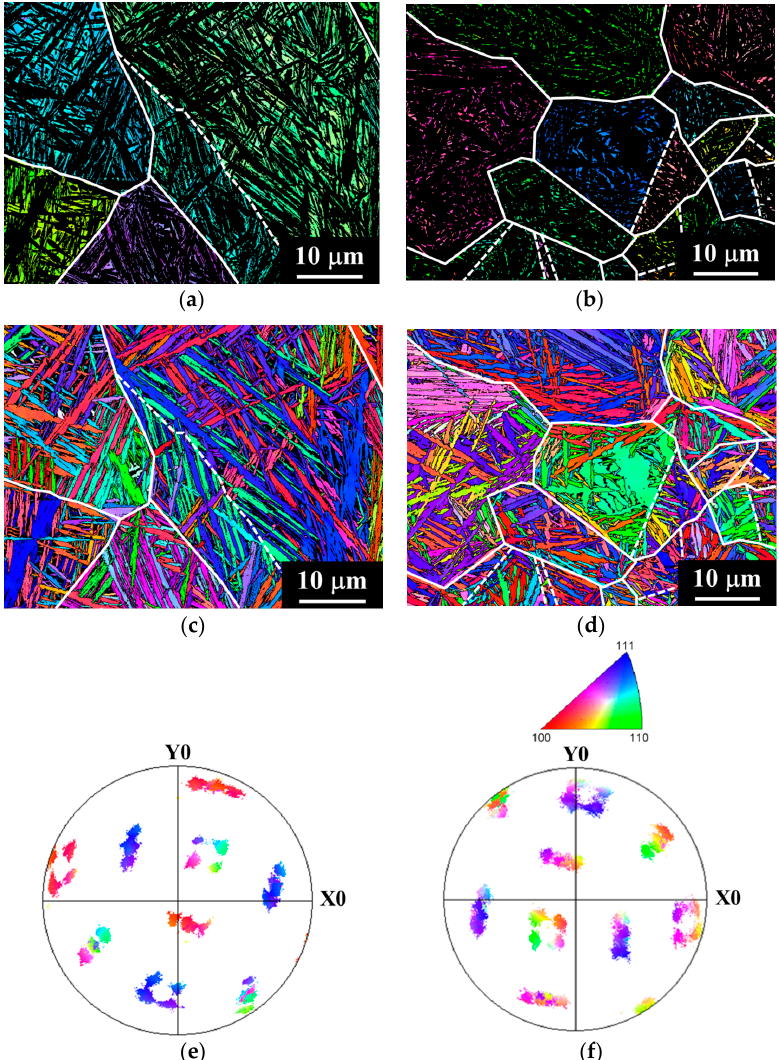
Figure 5. EBSD Inverse Pole Figure (IPF) of the austenite phase in ( a ) 1C-2.5Si-950-250-16 and ( b ) 0.6C-1.5Si-950-250-16 specimens; corresponding EBSD Inverse Pole Figure of the ferrite phase in ( c ) 1C-2.5Si-950-250-16 and ( d ) 0.6C-1.5Si-950-250-16 specimens; EBSD Pole Figure for the ferrite phase formed from a single prior austenite grain in ( e ) 1C-2.5Si-950-250-16 and ( f ) 0.6C-1.5Si-950-250-16 specimens. Prior austenite grains boundaries are delimited by solid white lines whereas prior austenite twin boundaries are delimited by dashed white lines.